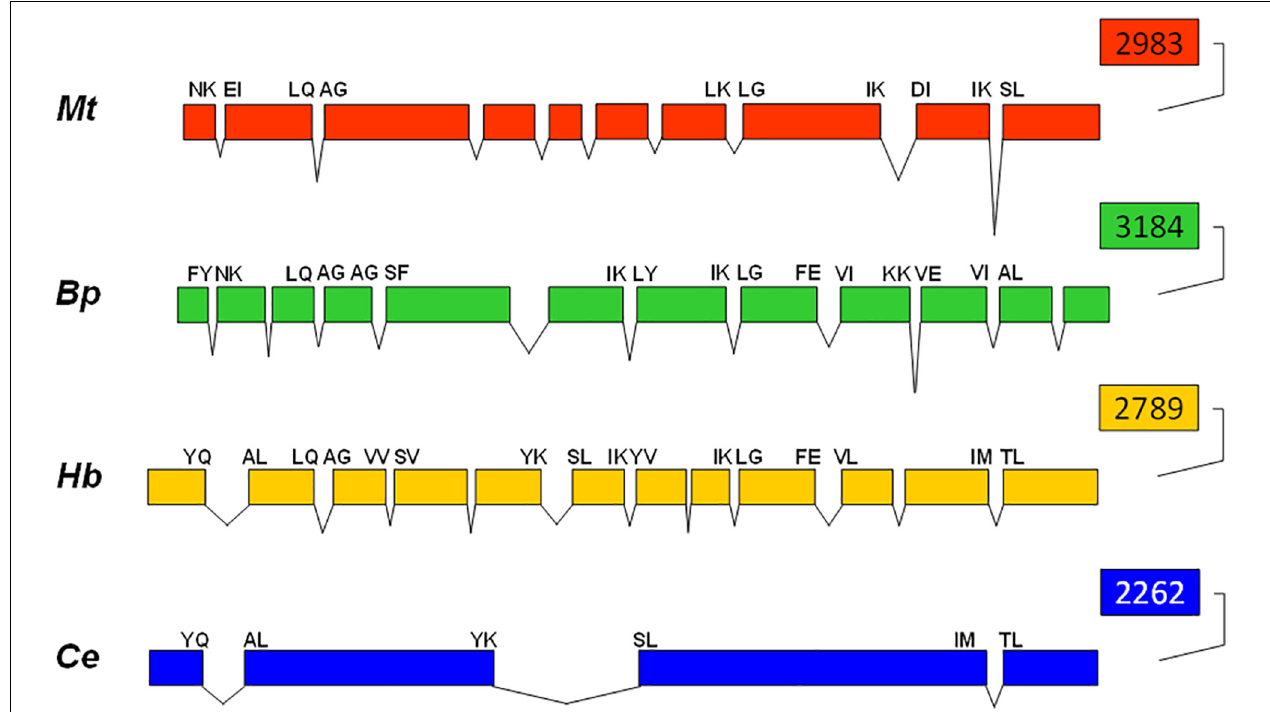
FIGURE 3 | Comparison of intron-exon structure of Hb - hsp 90-1 of Heterorhabditis bacteriophora compared with those of Meloidogyne artiellia , Brugia pahangi, and Caenorhabditis elegans . Exons are shown as boxes and introns as V-shaped lines. The amino acid at intron junctions indicated conserved positions between